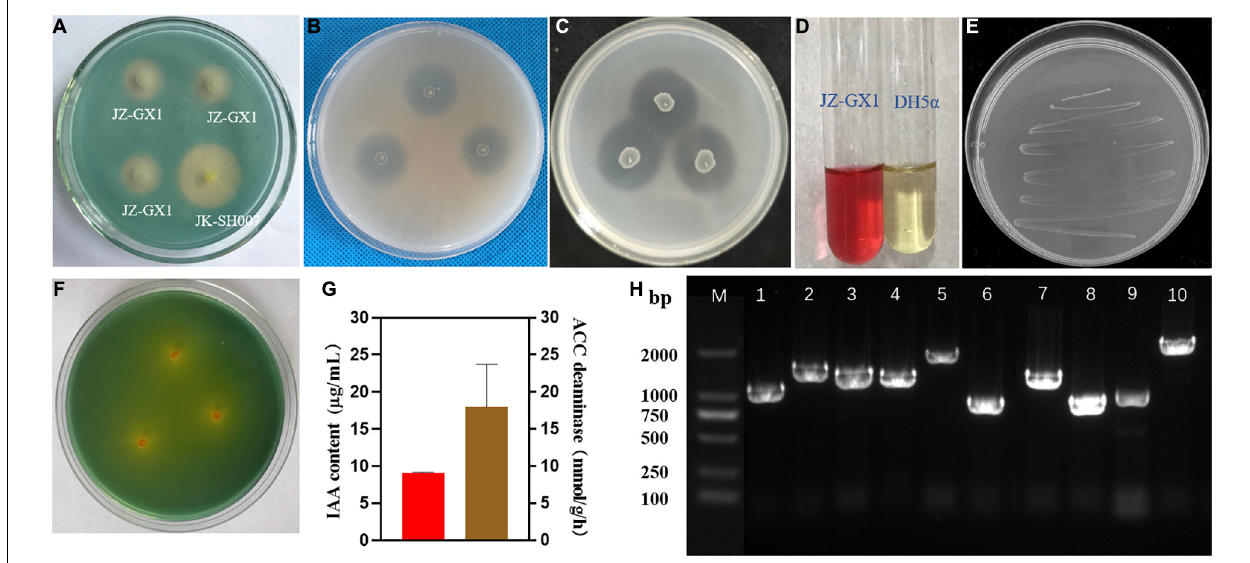
FIGURE 4 | Detection of plant growth-promoting characteristics of Rahnella victoriana JZ-GX1. (A) Siderophore production, (B) inorganic phosphorus dissolution, (C) organophosphorus dissolution, (D) acetoin production, (E) nitrogen fixation, (F) potassium solubilization, (G) IAA and ACC deaminase production, and (H) detection of key gene related to PGP traits in JZ-GX1 by PCR amplification (lane M, DNA marker; 1, acdS ; 2, gadB ; 3, gadD ; 4, gabT ; 5, speA ; 6, speD ; 7, G1pase ; 8, pstA ; 9, pstC ; 10, nirB ). One-way ANOVA was performed, and Duncan’s post-hoc test was applied. Different letters indicate statistically significant differences ( p < 0.01) among treatments ( n =